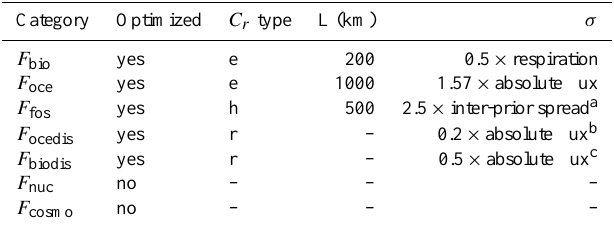
Table 1. Spatial flux error covariance parameters of Eq. (4) for dif- ferent